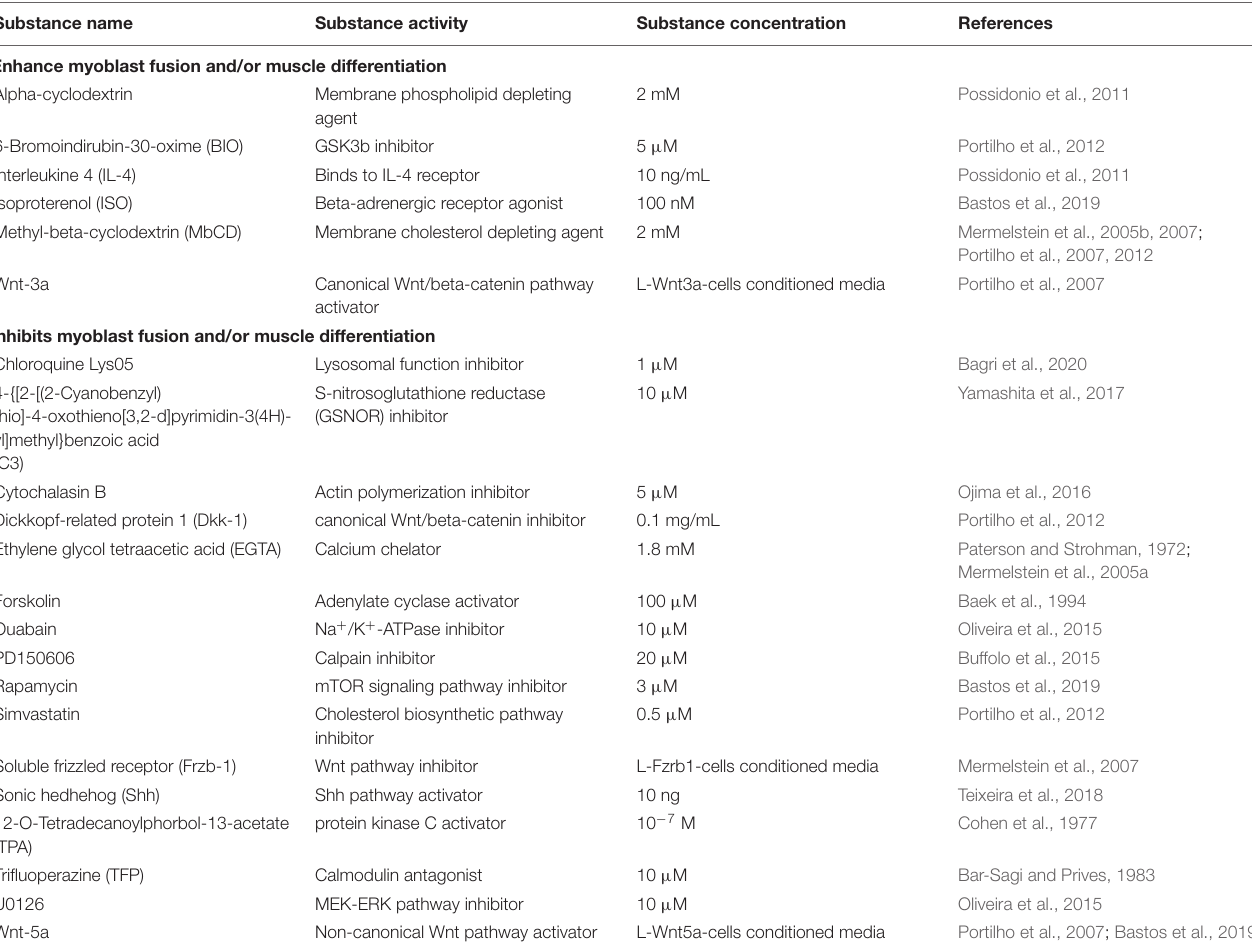
TABLE 2 | Pro- or anti-myogenic effects of different molecules/substances during in vitro chick skeletal